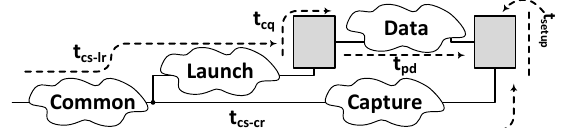
Figure 9: The Naming Convention for Different Sections, and Various Delay Components of a Timing